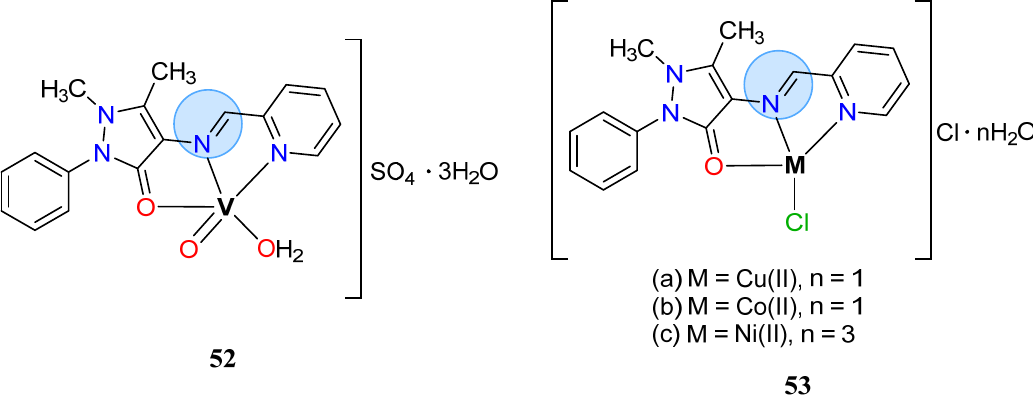
Figure 22. Metal complexes from 2-pyridinecarboxylidene-4-aminoantipyrine ligand with antimicrobial activity.